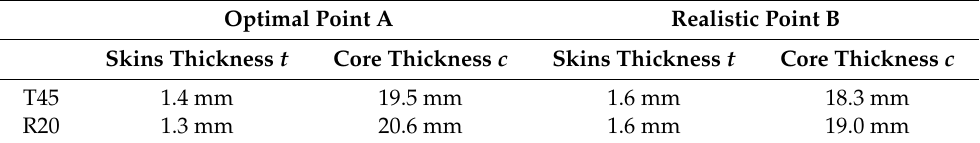
Figure 10. Optimisation results considering a ( a ) T45 and a ( b ) R20 core. Table 9. Numerical results of the optimisation procedures.